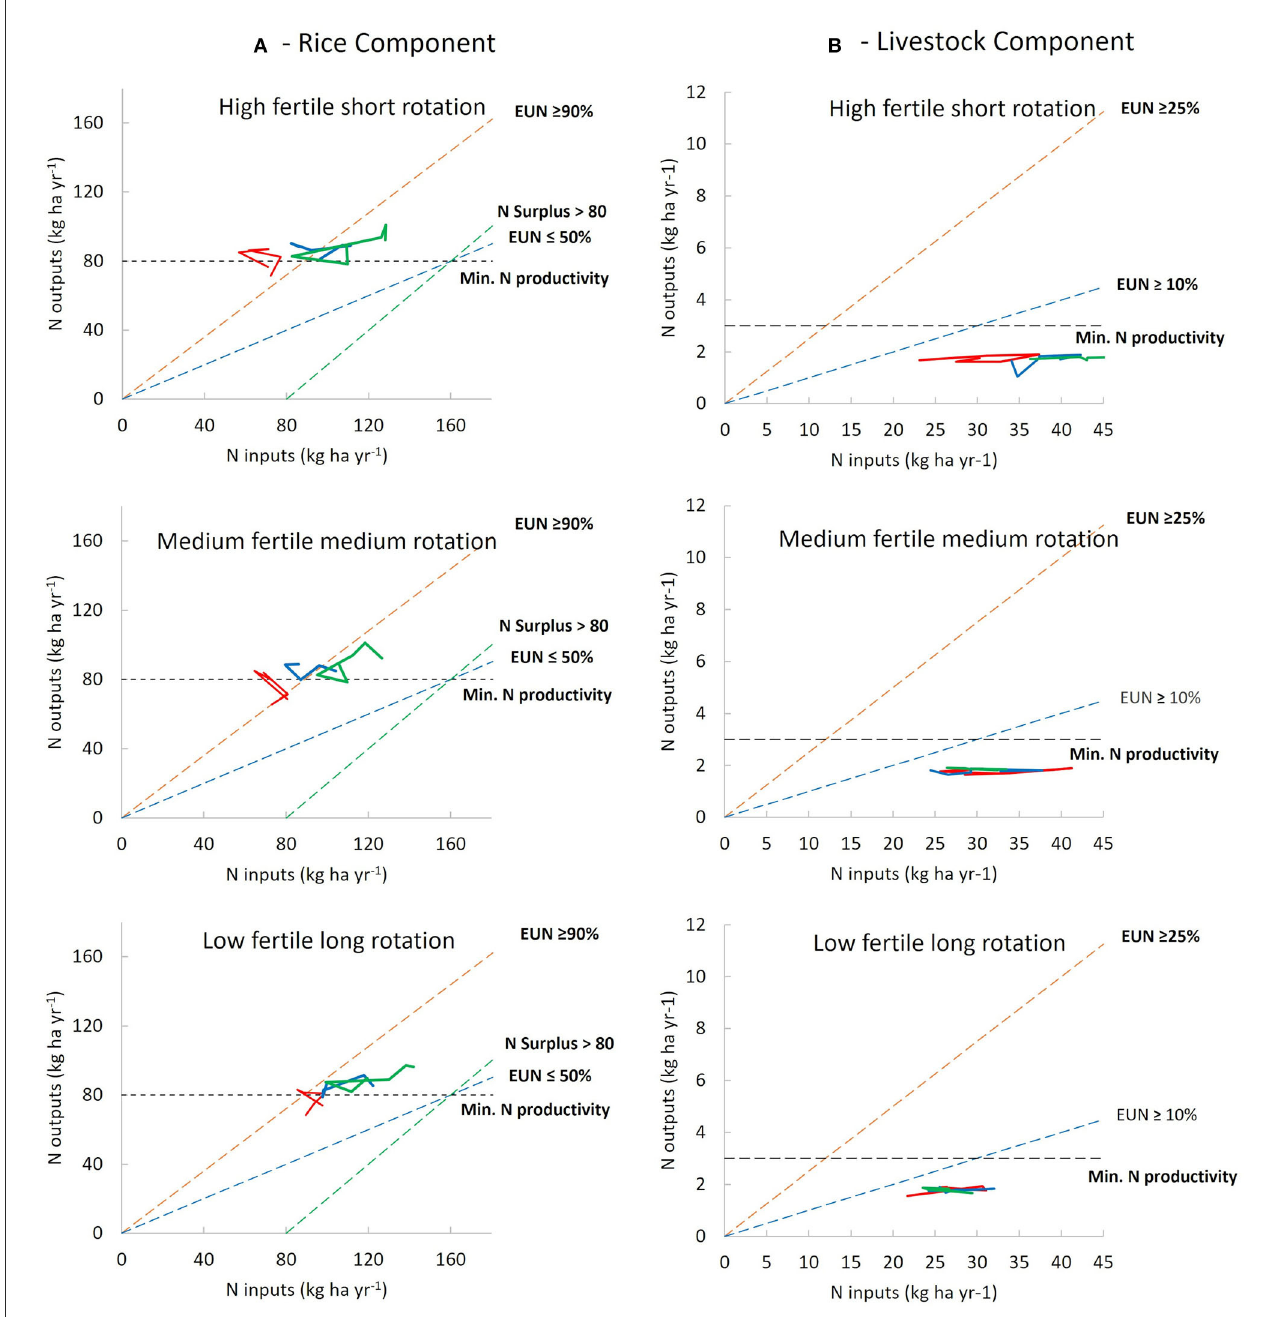
FIGURE2 Changes in N outputs in food products vs. N inputs in the 2004–2005 to the 2021–2022 growing seasons for the three regions: (A) rice component and (B) livestock component. Solid red, blue, and green lines indicate changes from 2004–2005 to 2009–2010, 2010–2011 to 2015–2016, and 2016–2017 to 2021–2022, respectively. The dashed orange and blue lines indicate NUE ( = outputs/inputs × 100) of 90 and 50%, respectively, for rice and 25 and 10%, respectively, for livestock. The dashed black lines indicate the expected N output for a desirable level of production and the dashed green lines indicate the maximum admissible N